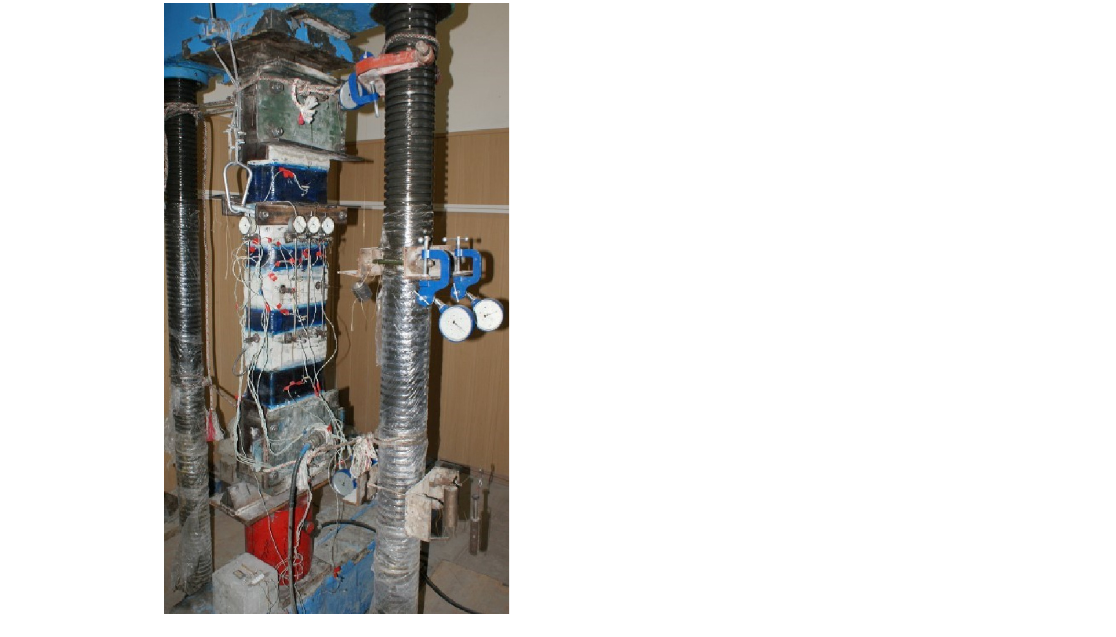
Figure 7. The design of the stand for testing columns with the location of mechanical devices and resistance strain gauges for measuring displacements and relative deformations. Loading of prototypes was carried out using a DG-200 jack, developing a force of N = 2000 kN. The load on the columns was transmitted by two multidirectional forces through the blades of triangular isosceles knives. The latter were installed on a jack and under the top plate of the press. The force from the knives to the column was transmitted